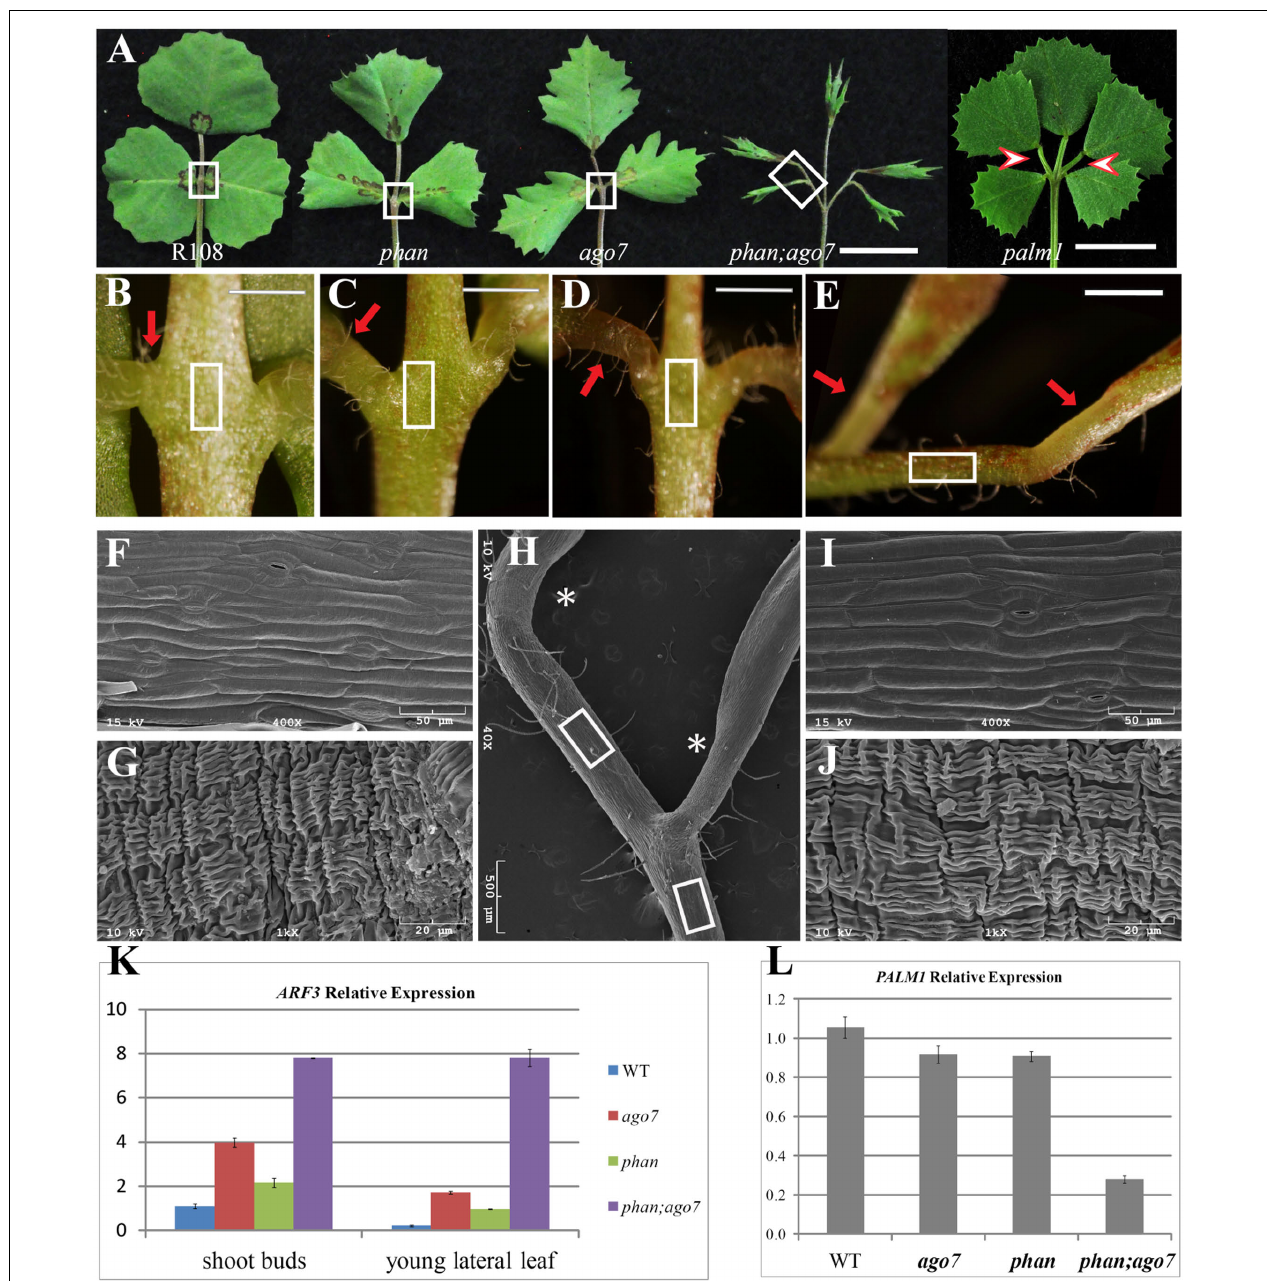
FIGURE 5 | Altered compound leaf patterning in mtphan;mtago7 double mutant. (A) The adaxial view of mature leaves in wild type (R108), and mtphan , mtago7 , mtphan;mtago7 and palm1 mutants (from left to right). The mtphan;mtago7 double-mutant leaves were palmate-like pentafoliate with narrow blades and elongated petiolules, in contrast to trifoliate leaves in wild type, and mtphan and mtago7 mutants. Scale bar, 1 cm. Red arrowheads indicate rachises in palm1 mutants. (B–E) Enlarged views of boxed regions in (A) , showing the junction between lateral leaflets and petiole in R108 (B) , mtphan (C) , mtago7 (D) and mtphan;mtago7 (E) . Scale bars: 2 mm. (F) A representative SEM image of adaxial epidermal cells of the petiole (boxed areas in B–D ). (G) A representative SEM image of epidermal cells of pulvinus (red arrows in B–D ). (H) SEM image of the boxed region from the mtphan;mtago7 mutant in (A) . (I) SEM image of epidermal cells of petiolule (boxed regions in E,H ) in the mtphan;mtago7 mutant. Note that epidermal cells of petiolule resemble epidermal cells of rachises in WT, and mtphan and mtago7 mutants. (J) SEM image of pulvinus (arrows in E ; asterisks in H ) in the mtphan;mtago7 mutant. (K,L) Quantitative RT-PCR analysis of expression of MtARF3 in vegetative shoot buds and young leaves (K) and PALM1 in vegetative shoot buds (L) in WT, mtago7 , mtphan , and mtphan;mtago7 mutants. Note that the expression level of PALM1 is negatively correlated with that of MtARF3 . Shown are means ± SD; n = 3.